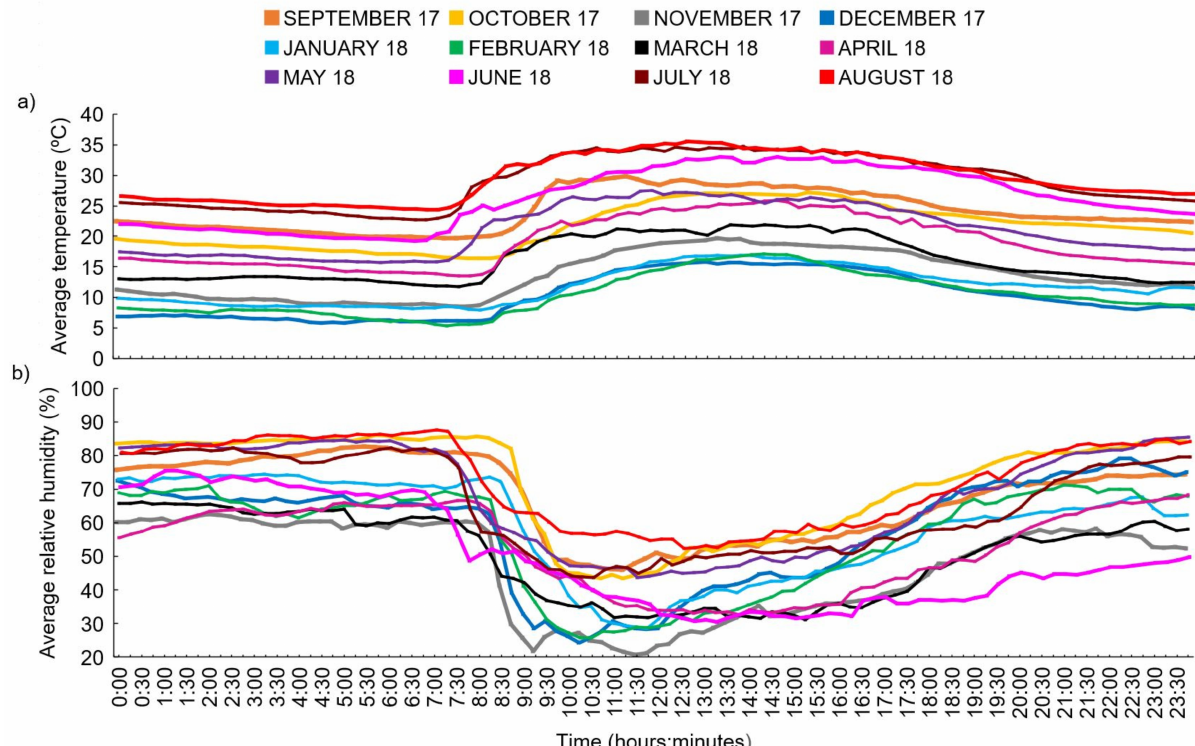
Figure 3. ( a ) Ambient average temperature ( ◦ C) and ( b ) average relative humidity (%) every 15 min during the day, comparing the 12 months of the